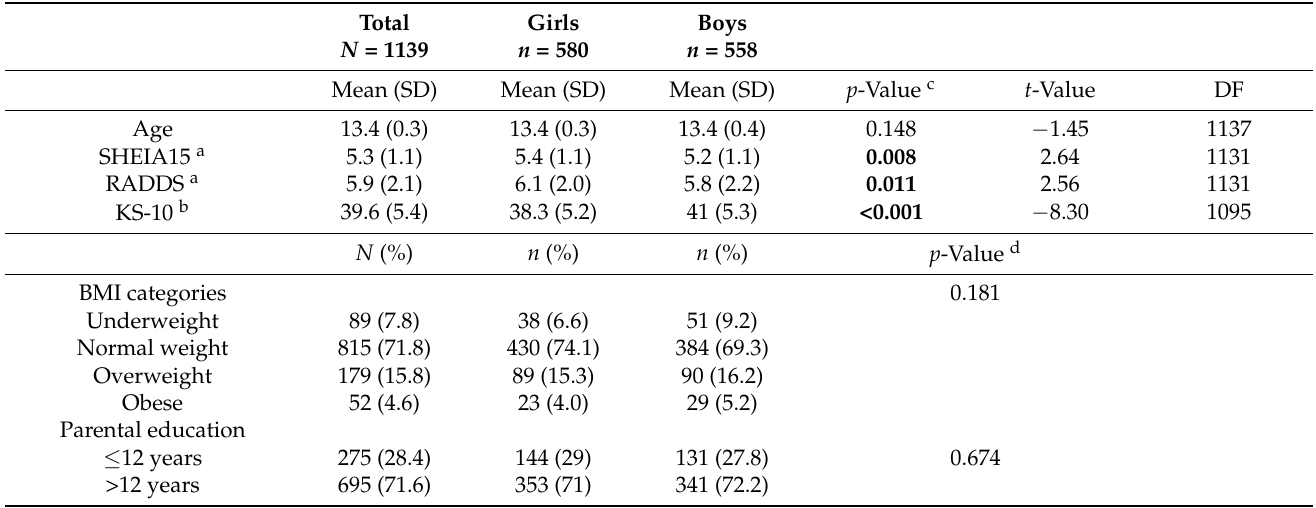
Table 1. Descriptives of participants divided by